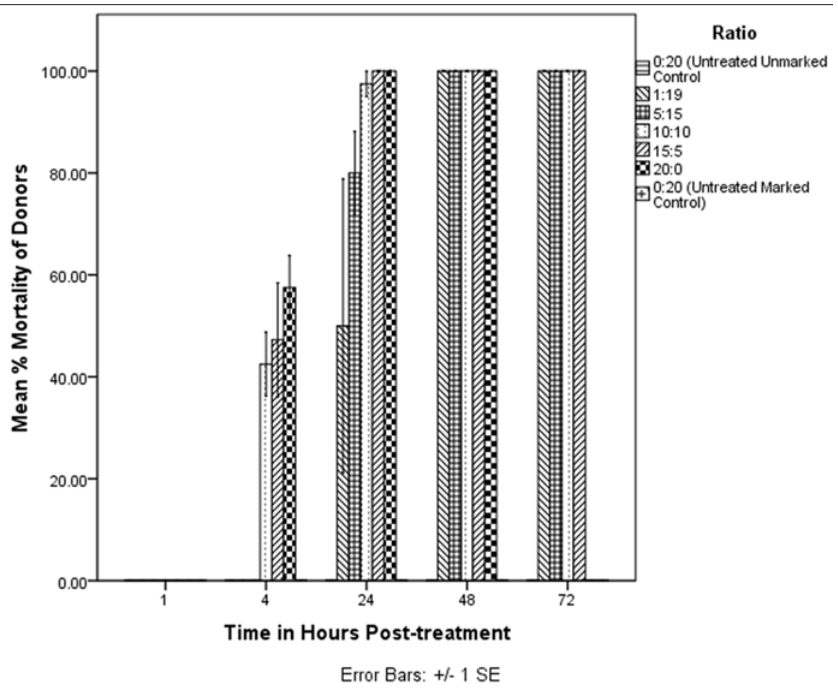
Fig. 8. Mean % mortality of donor populations in varying cohorts of donor:recipient Reticulitermes flavipes termites through time when donors were exposed for 30 minutes to soil treated with Termidor ® HE at 0.12%